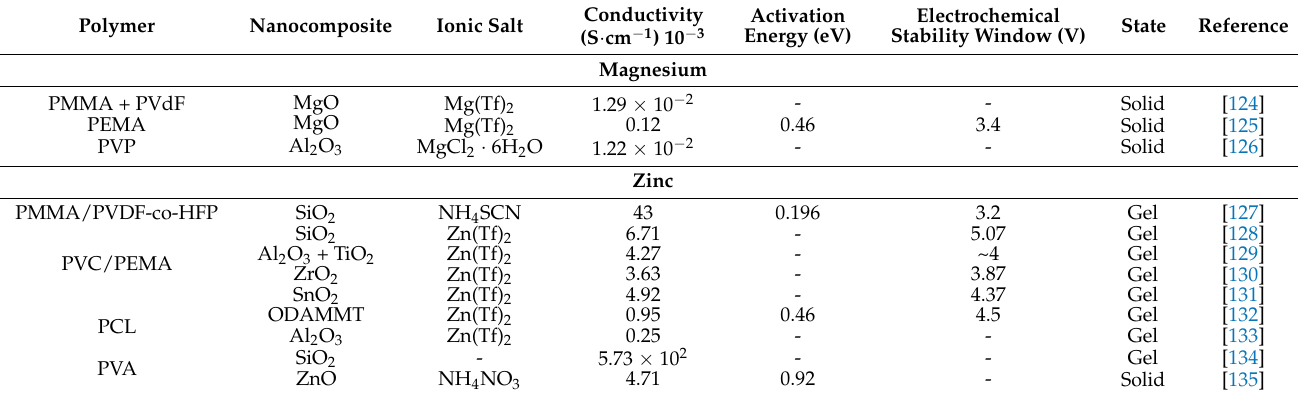
Table 6. NCPEs for magnesium and zinc batteries using other synthetic polymers.